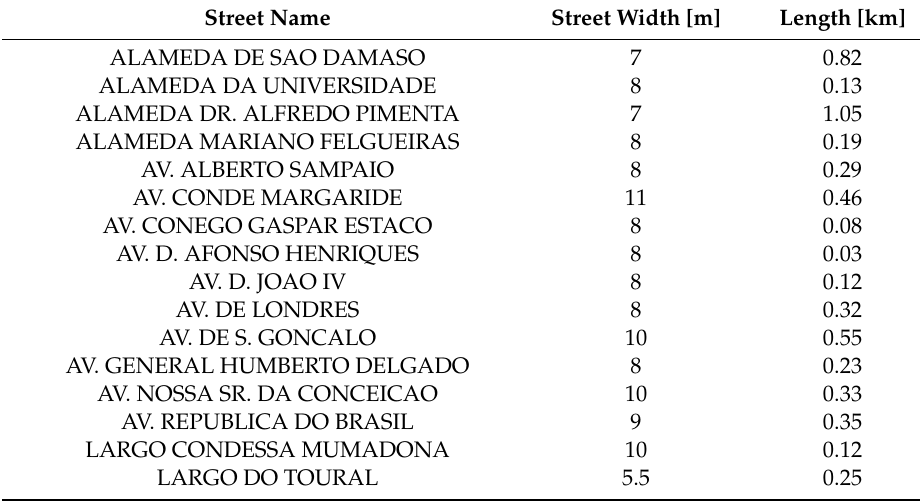
Table A1. Roads included in the noise